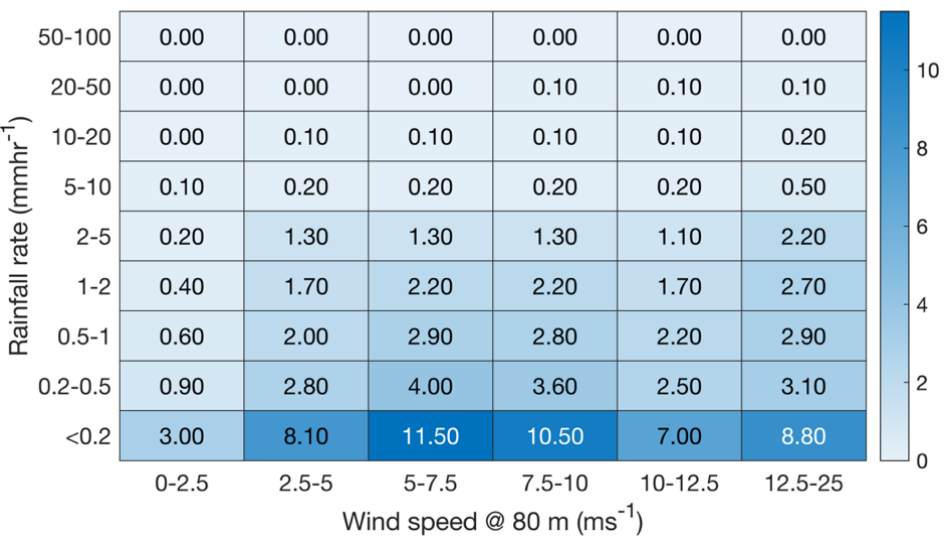
Figure 11. Heatmaps of the joint probabilities (in %, colorbar and also numeric values shown in each cell) of RR and wind speeds at coastal Canada. The joint probabilities are computed for periods with precipitation and thus the sum of all cells is 99.8% since 0.2% of wind speeds are above 25 ms − 1 .